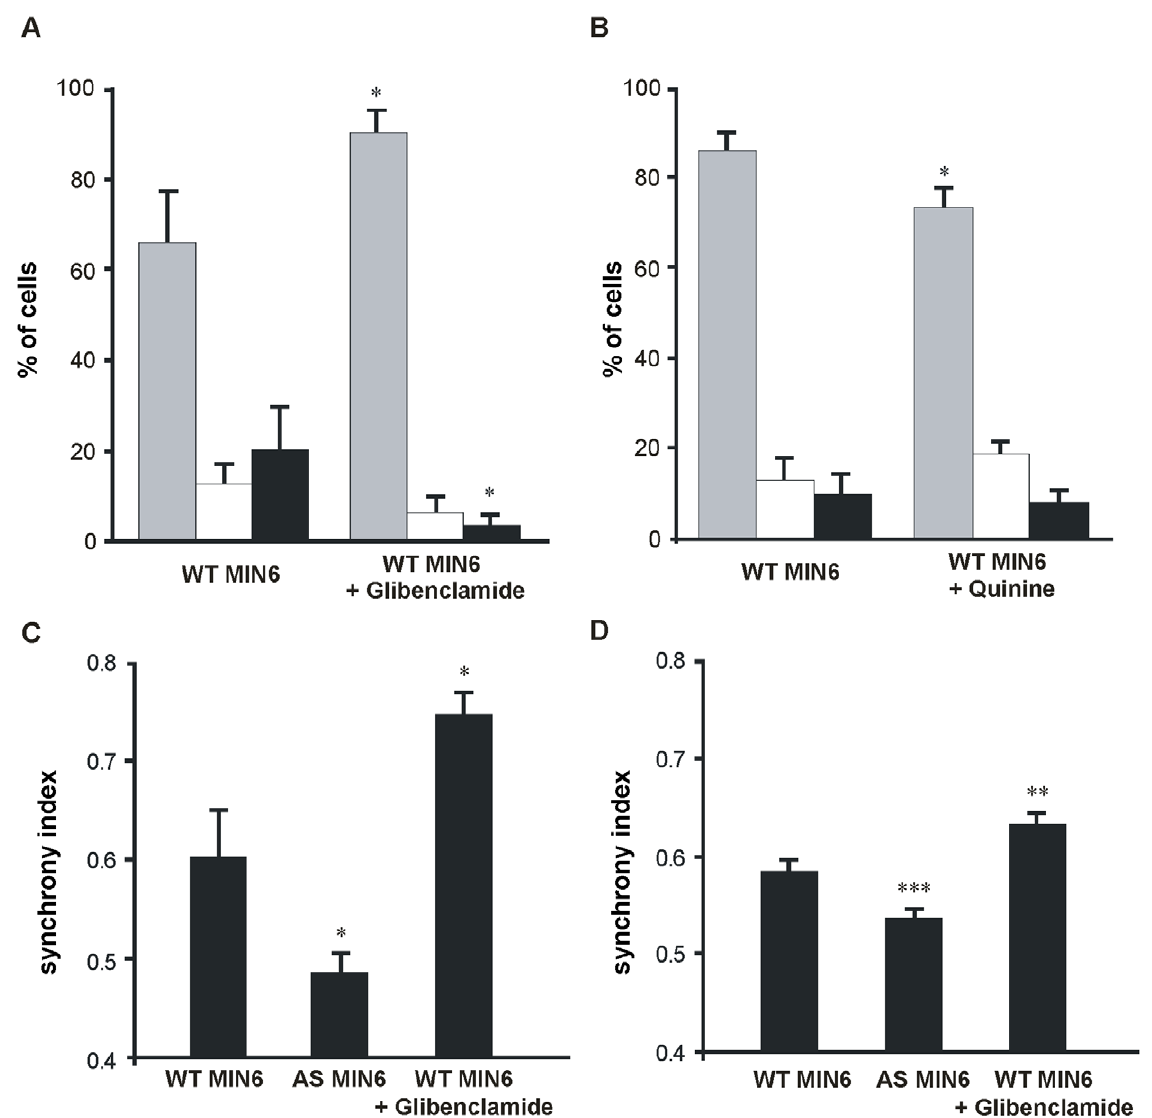
Figure 2. Glibenclamide and quinine differentially modulate the intercellular synchronization of glucose-induced Ca 2 + oscillations. ( A ) During stimulation by 20 mM glucose in the presence of 15 mM TEA, MIN6 cells exposed for 24 h to 10 m M glibenclamide showed increased proportion of synchronous cells ( gray bars ) compared to control, but decreased proportions of asynchronous ( white bars ) and silent cells ( black bars ); ( B ) Under the same conditions, MIN6 cells exposed for 24 h to 10 m M quinine, showed a reduced proportion of synchronous cells ( gray bars ). Bars show means + SE values of three independent experiments. *p , 0.05 versus values of WT MIN6 cells; ( C ) The synchrony index of WT MIN6 cells, as evaluated using a NIPKOW confocal microscope, was about 0.6. This value was decreased in AS MIN6 cells, and increased after exposure of the cells to glibenclamide; ( D ) Similar values of synchrony index data were semi-automatically calculated, in the same cell types, using an ImageXpress microscope. Data are means + SE of seven clusters measured for each condition in C, and 87 clusters measured for each condition in D. *p , 0.05, **p , 0.01 and ***p , 0.001 versus values of WT MIN6 cells.